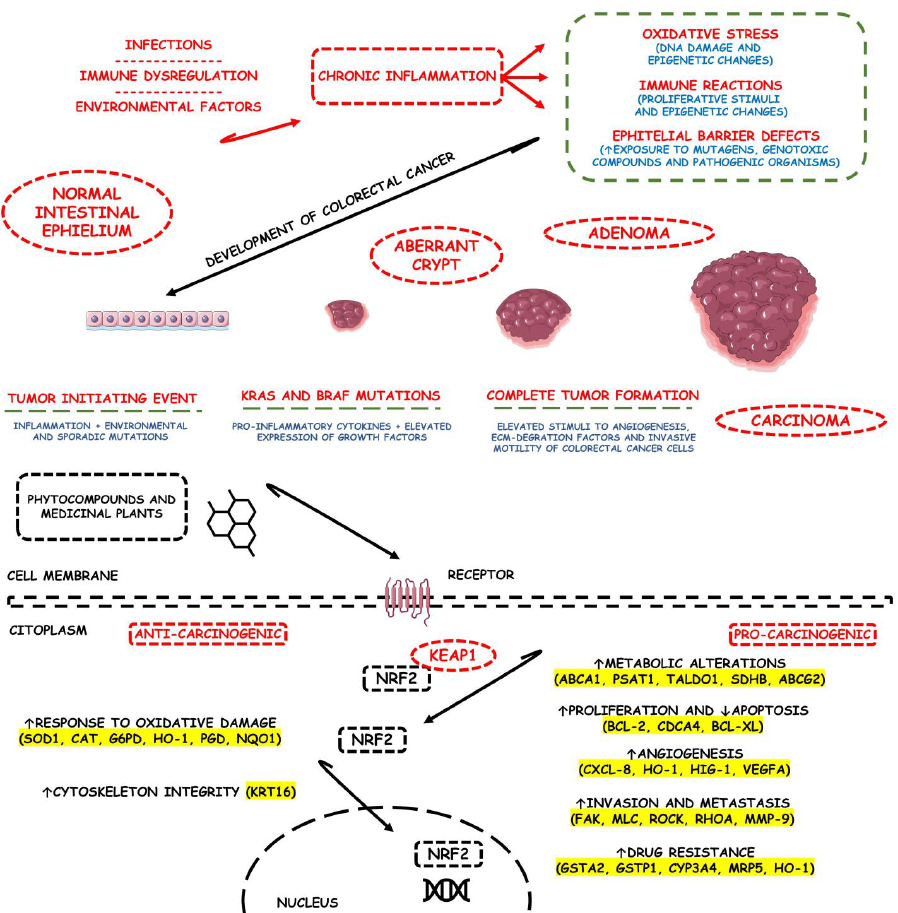
Figure 3. Physiopathology of colitis-associated tumorigenesis and the roles of Nrf2 in this condition. ↑ , increase; ↓ , decrease; ABCA1, ATP-binding cassette transporter ABCA1; ABCG2, ATP